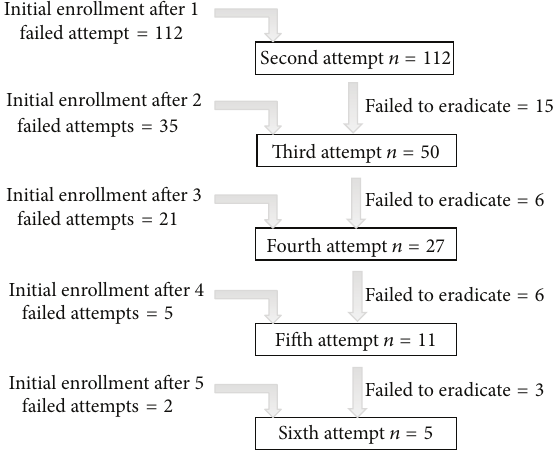
Figure 2: Patient enrollment. Patients referred for salvage therapy were initially enrolled after failing 1–5 attempts at H. pylori therapy with their referring physician. Salvage therapy was offered within thisstudyassecondtosixthattemptsandthosefailingtheseattempts wereofferedsubsequentsalvagetherapywithinthestudy.The“failed to eradicate” numbers in the figure refer to those failing therapy and continuing to participate in the next treatment